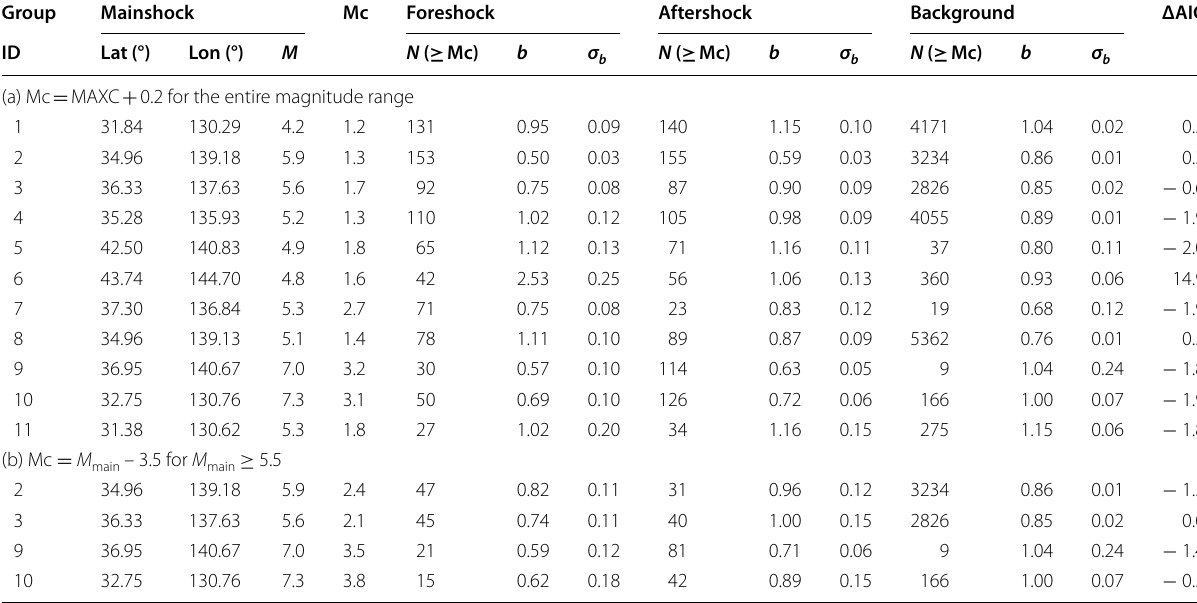
Lat., Lon., and M indicate the latitude, longitude, and magnitude of the mainshock, respectively. Mc indicates the completeness magnitude. The parameters, b and σ b , are the b -value and its uncertainty, respectively. ΔAIC indicates the difference of AIC values (Utsu 1999). a Mc was chosen as MAXC range, b Mc was chosen as M main